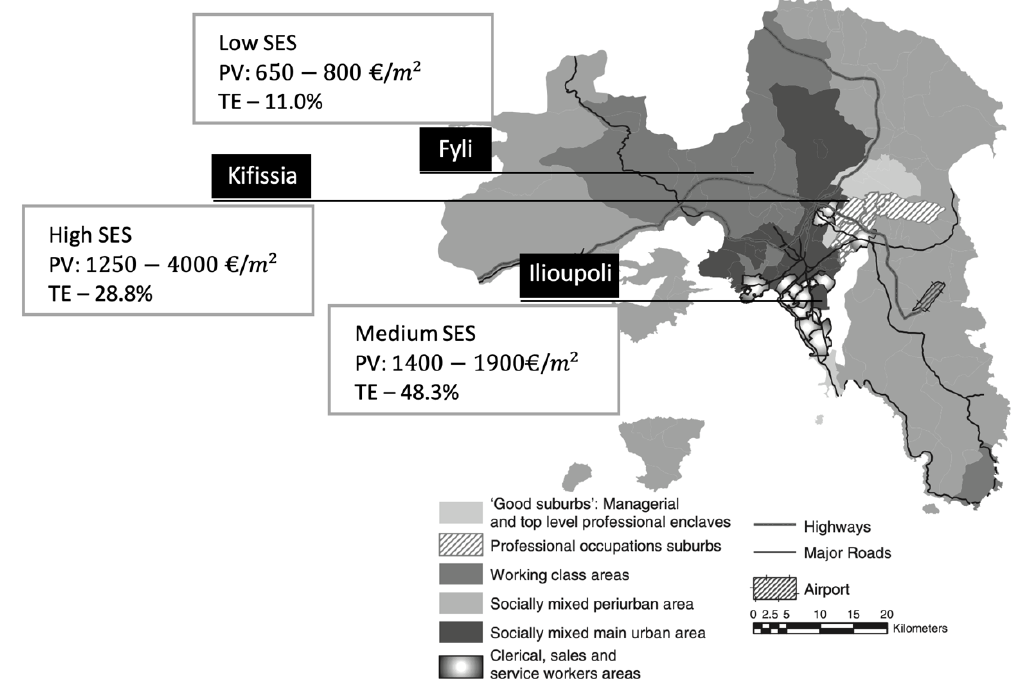
Figure 1 The occupational structure of Athens ( Arapoglou & Sayas 2009